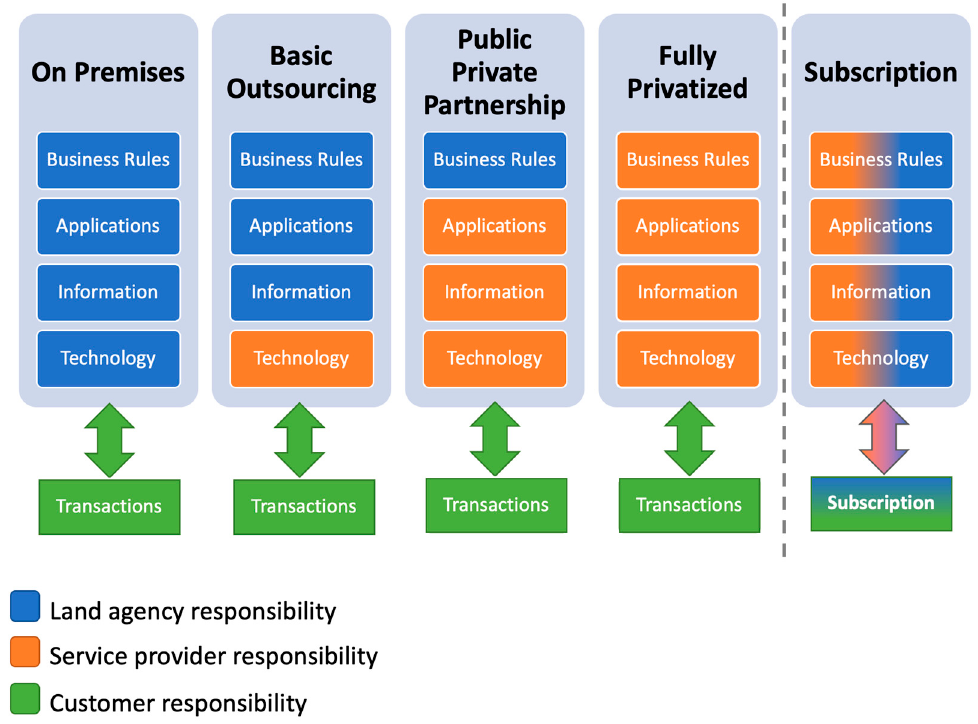
Figure 5. Options, actors, and responsibilities in aaS for land administration.